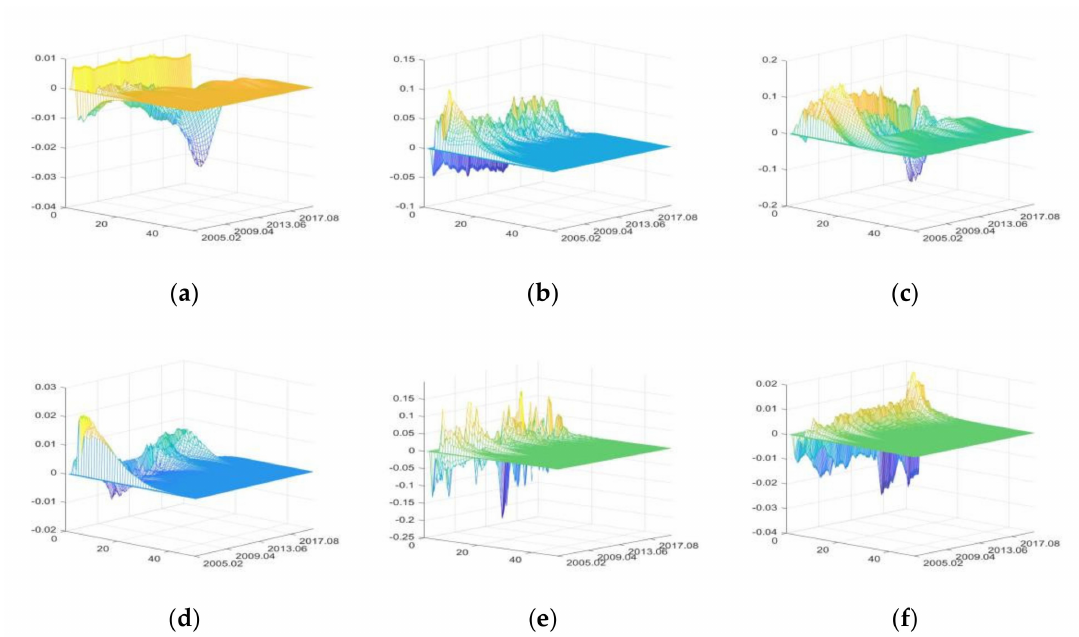
Figure 7. The three-dimensional impulse responses of PAE to positive shocks of external uncertainties. ( a ) Shocks of IRU. ( b ) Shocks of FU. ( c ) Shocks of SDU. ( d ) Shocks of CU. ( e ) Shocks of DE. ( f ) Shocks of